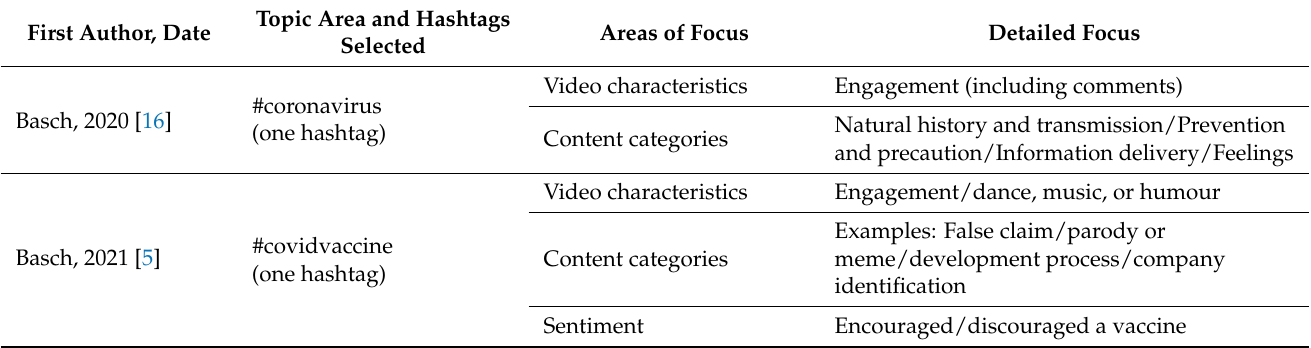
Table 1. Overview of selected investigations of health-related topics on